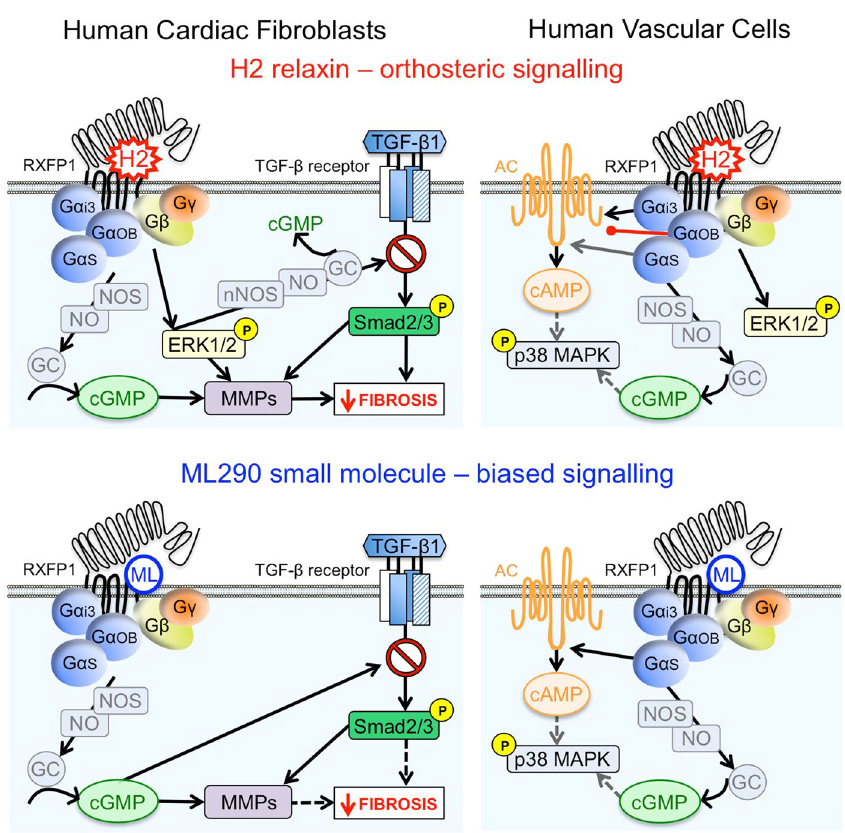
Figure 8. Comparison of signalling pathways activated by ML290 and H2 relaxin through RXFP1 expressed in human primary vascular cells and myofibroblasts. In human primary myofibroblasts both H2 relaxin and ML290 have a profile corresponding to anti-fibrotic activity yet ML290 achieves this without activating ERK. In human primary vascular cells H2 relaxin activates cAMP, cGMP and pERK with similar potency whereas ML290 is biased towards cGMP signalling compared with cAMP and does not activate